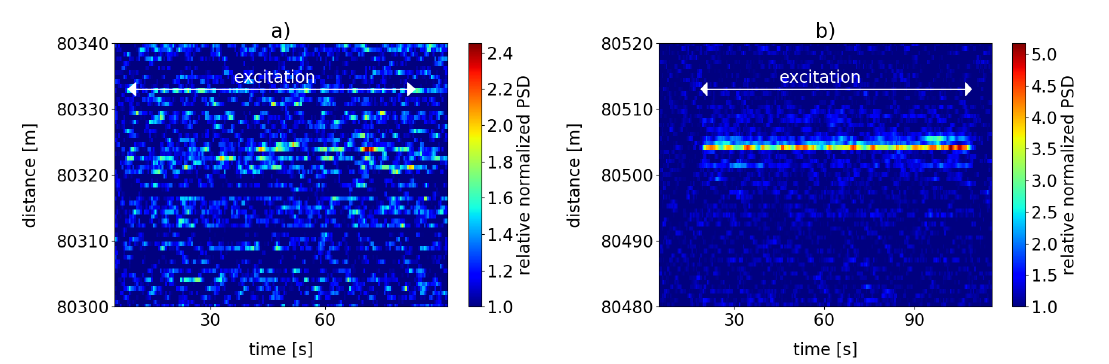
Figure 14. Normalized PSD sum (Equation (8)) at excitation frequency f = 25 Hz and its harmonics at a measurement distance of more than 80 km. ( a ) for unmodified standard SMF; ( b ) for the modified sensing fiber with inscribed scattering dots. Note the different scales of the color